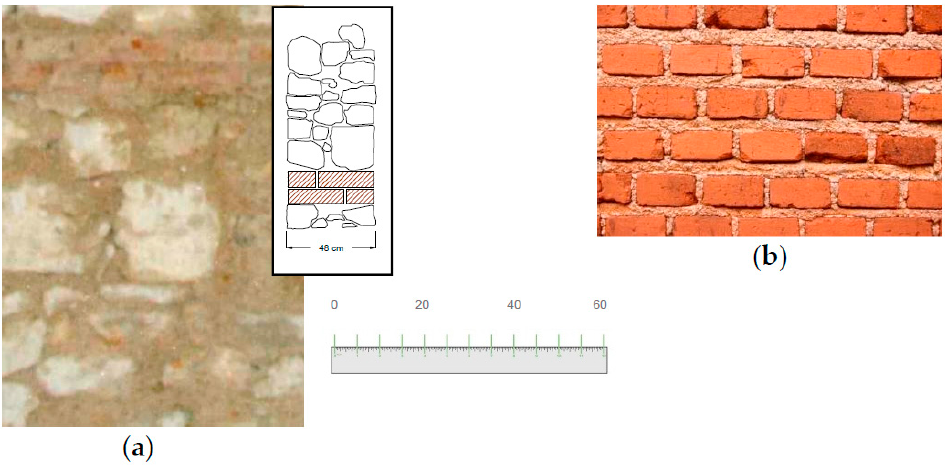
Figure 2. Masonry typologies of Building No. 1: ( a ) Stone work; ( b ) Brickwork, [dimensions in cm].